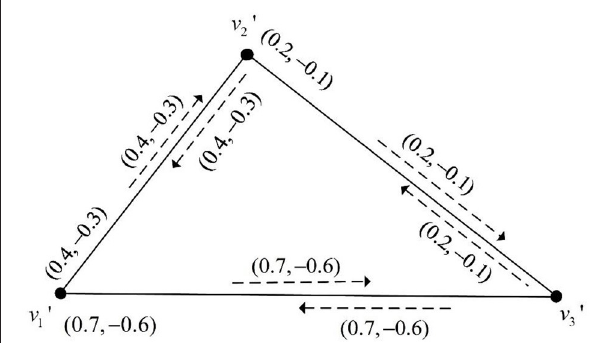
fuzzy incidence graphs. If WI BFI ( G 1 ) = WI BFI ( G 2 ), then WAI BFI ( G 1 ) = WAI BFI ( G 2